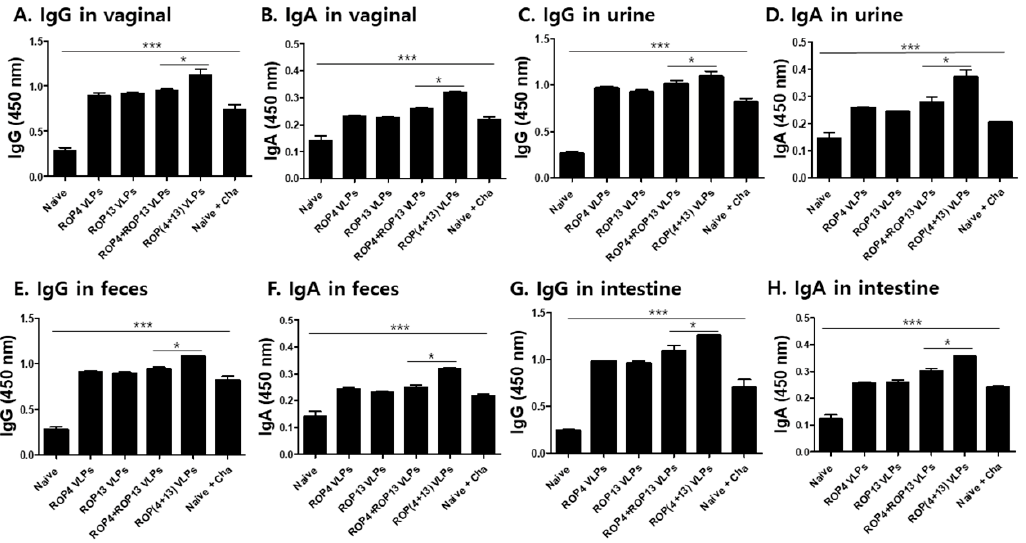
Figure 3. Intranasal immunization with T. gondii VLPs induced mucosal immunity. Mice ( n = 10) were intranasally immunized with ROP4 VLPs, ROP13 VLPs, ROP4 + ROP13 VLPs and ROP(4 + 13) VLPs. Mice samples were collected at day 30 after challenge infection with T. gondii ME49. To confirm the activation of mucosal immunity, we identified IgG and IgA antibody responses from vaginal secretions, urine, feces and intestines. IgG and IgA antibody responses from vaginal secretions (( A , B ), * p < 0.05, *** p < 0.001). IgG and IgA antibody responses in urine (( C , D ), * p < 0.05, *** p < 0.001). IgG and IgA antibody responses in feces (( E , F ), * p < 0.05, *** p < 0.001). IgG and IgA antibody response in intestine (( G , H ), * p < 0.05, *** p <